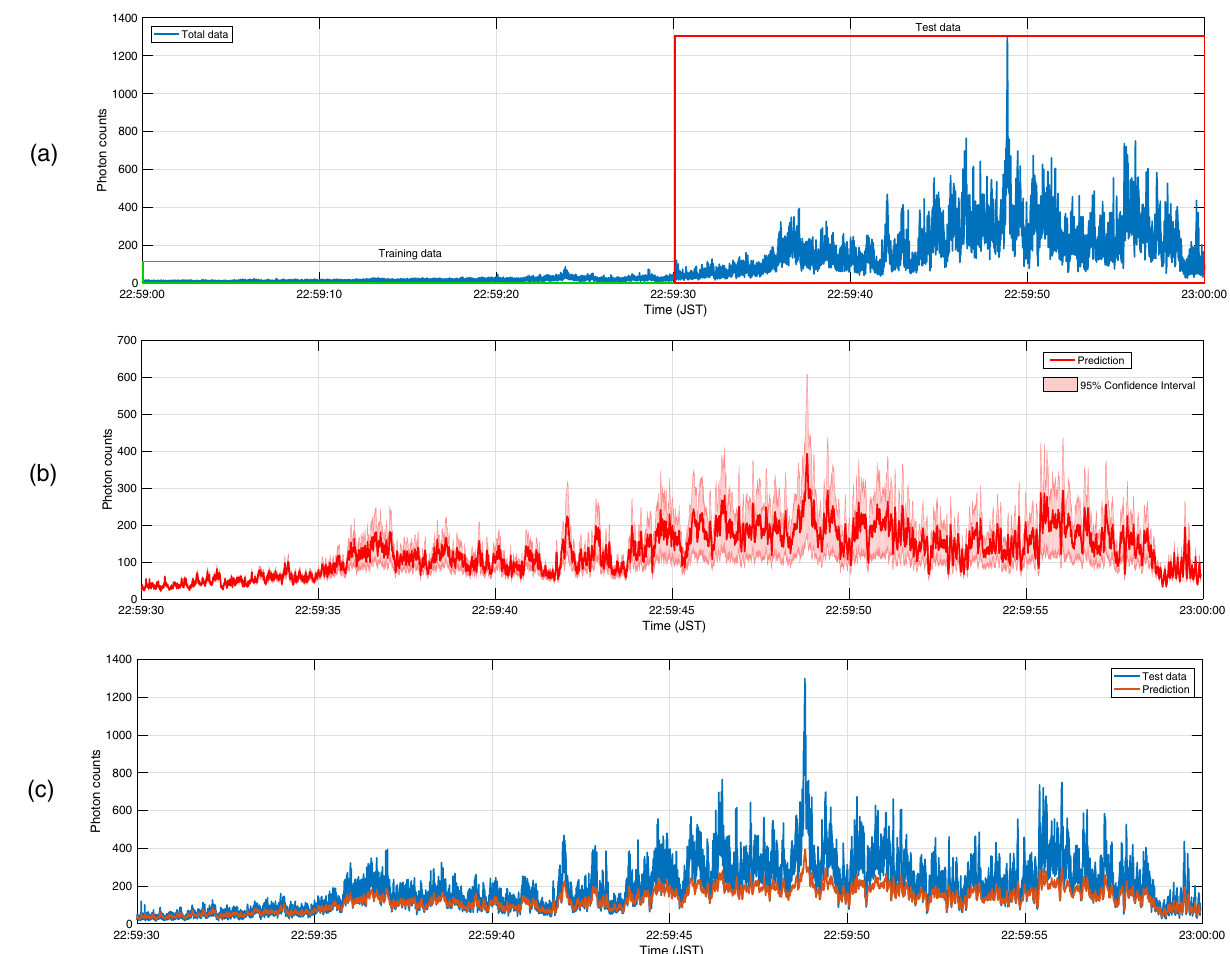
Fig. 8 Training and test datasets with prediction results. In a , we show the total photon-count data in 1 min (22:59:00 – 23:00:00 JST) on 5 August 2016, with the counting interval of 1 ms. The total data are divided into two datasets, where the fi rst 30-s data are used in the training stage and the last 30-s data are used as the test data to validate the photon-count predictions. In b , the predicted photon counts during 30 s (22:59:30 – 23:00:00 JST), averaged over 10 runs together with 95% con fi dence interval, are plotted. In c , the average prediction result in b is compared with the test data in a